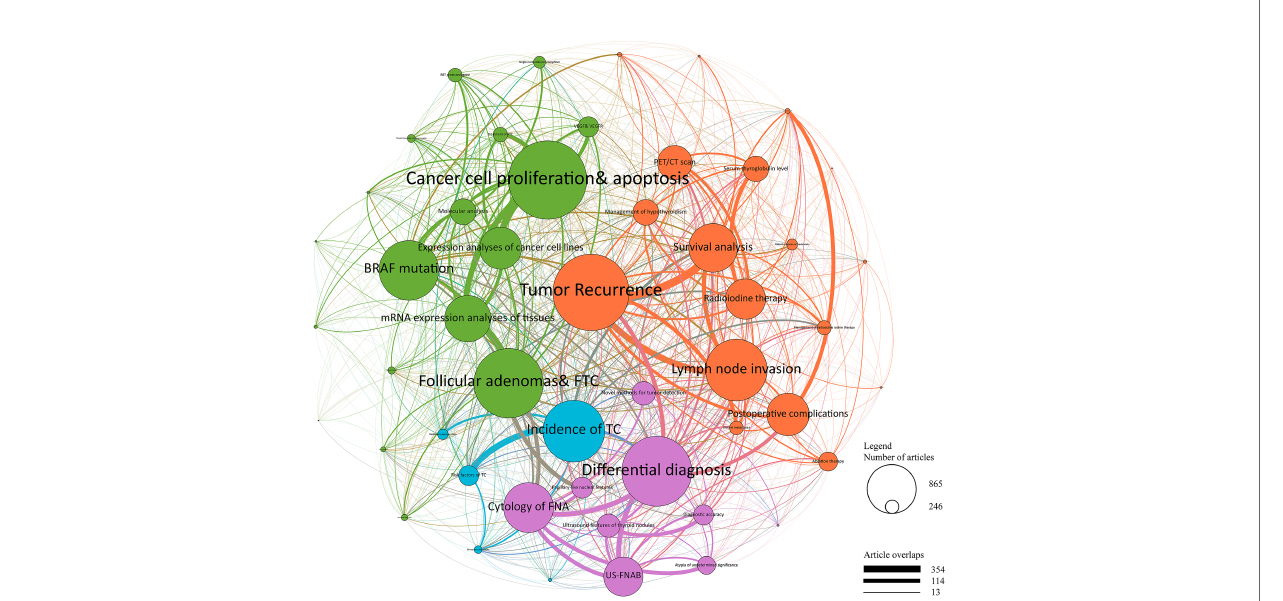
FIGURE 5 | Topic cluster network by Latent Dirichlet Allocation. Red, Treatment management; Green, Basic research; Purple, Diagnosis research; Blue, Epidemiology and cancer risk. The size of circle represents the number of papers in each topic, and the thickness of line represents the weight of connection between each topic.